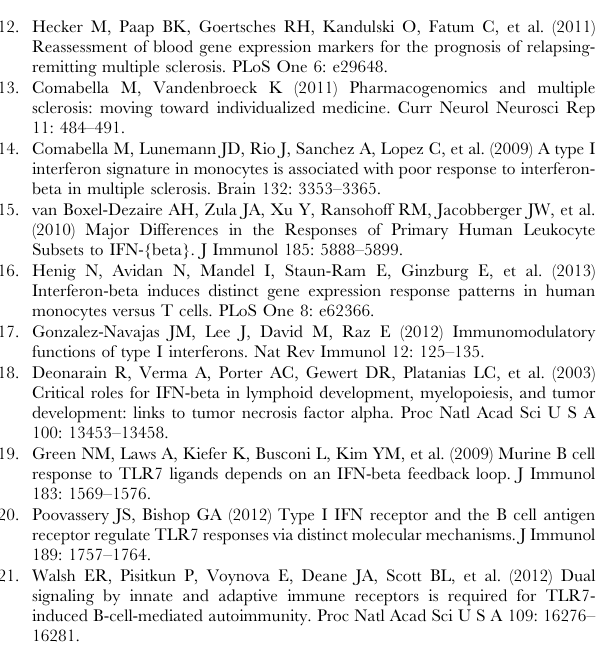
Table S2 Differentially expressed genes up-regulated in response to IFN- b . Table S3 Top 20 differentially expressed genes down- regulated in response to IFN- b